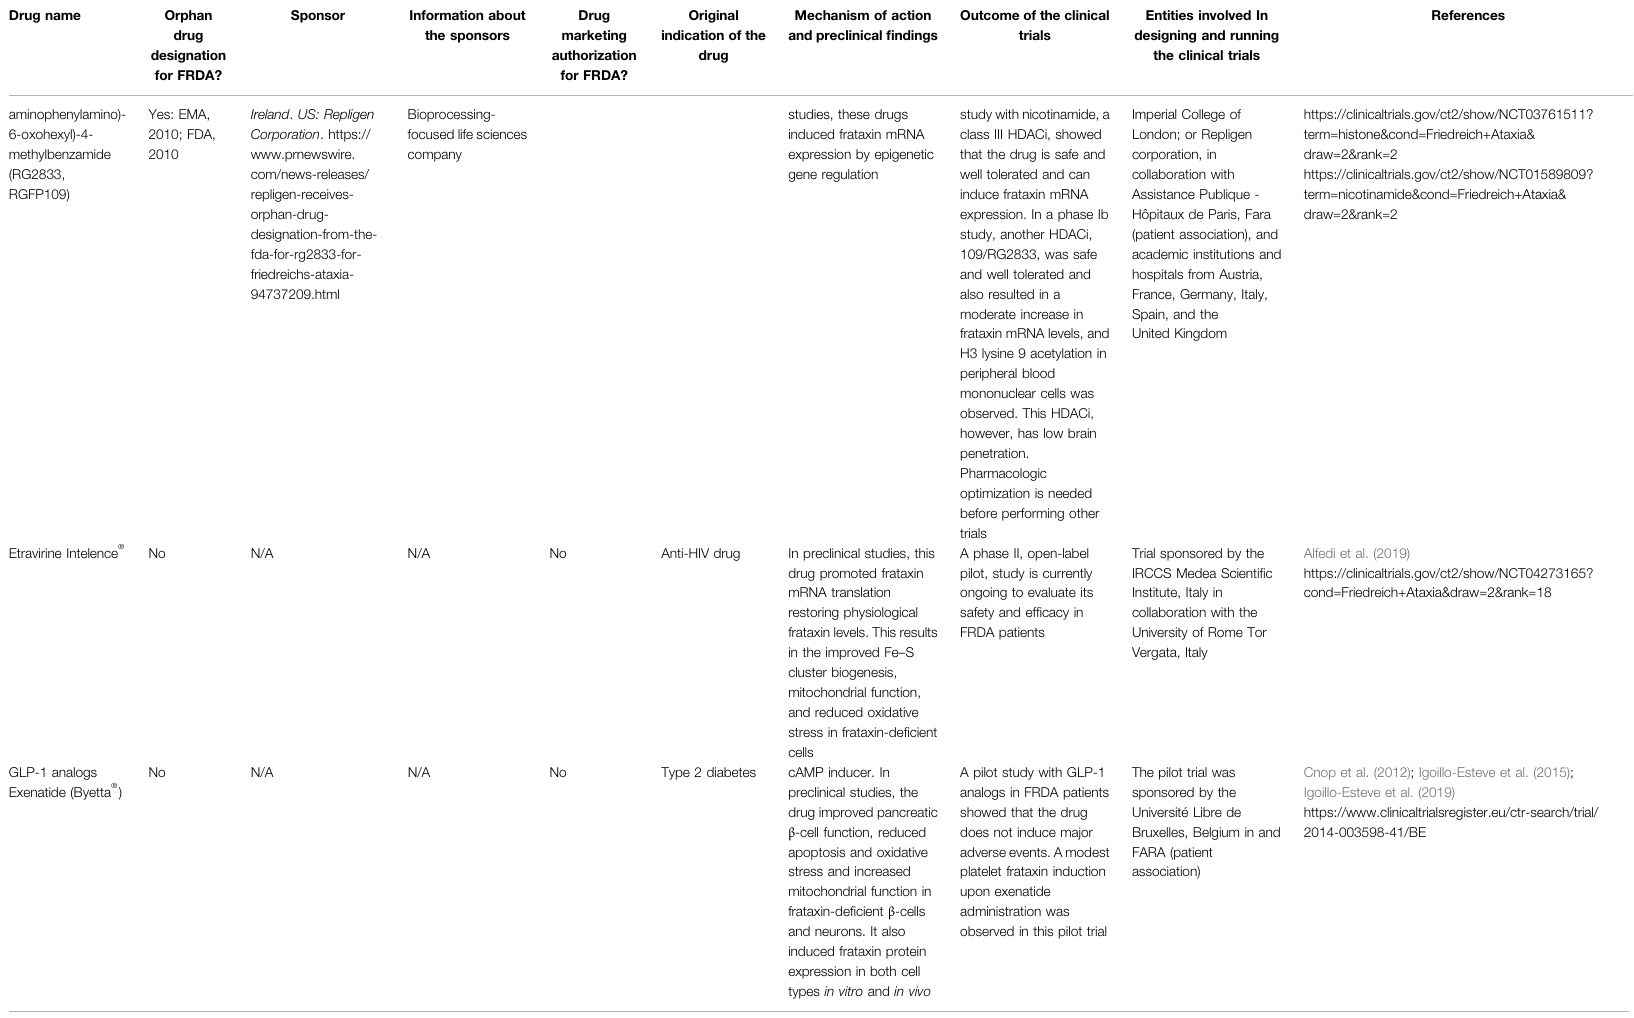
TABLE 2| ( Continued ) List of the repurposed drugs, with and without orphan designation or drug marketing authorization for Friedreich ’ s ataxia (FRDA) mentioned in this article. The sponsors (entities involved in making the orphan designation request to EMA or the FDA), and the public or private organizations involved in designing and running the clinical trials are detailed. N/A (cid:1)